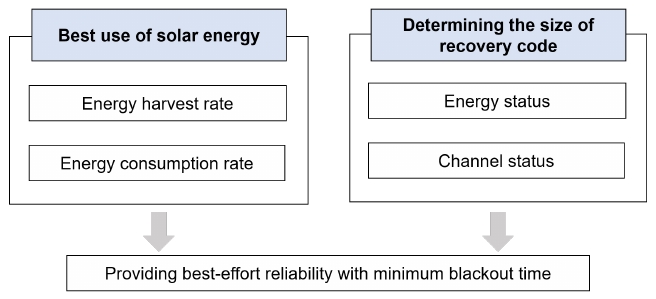
Figure 1. Contributions of the proposed scheme